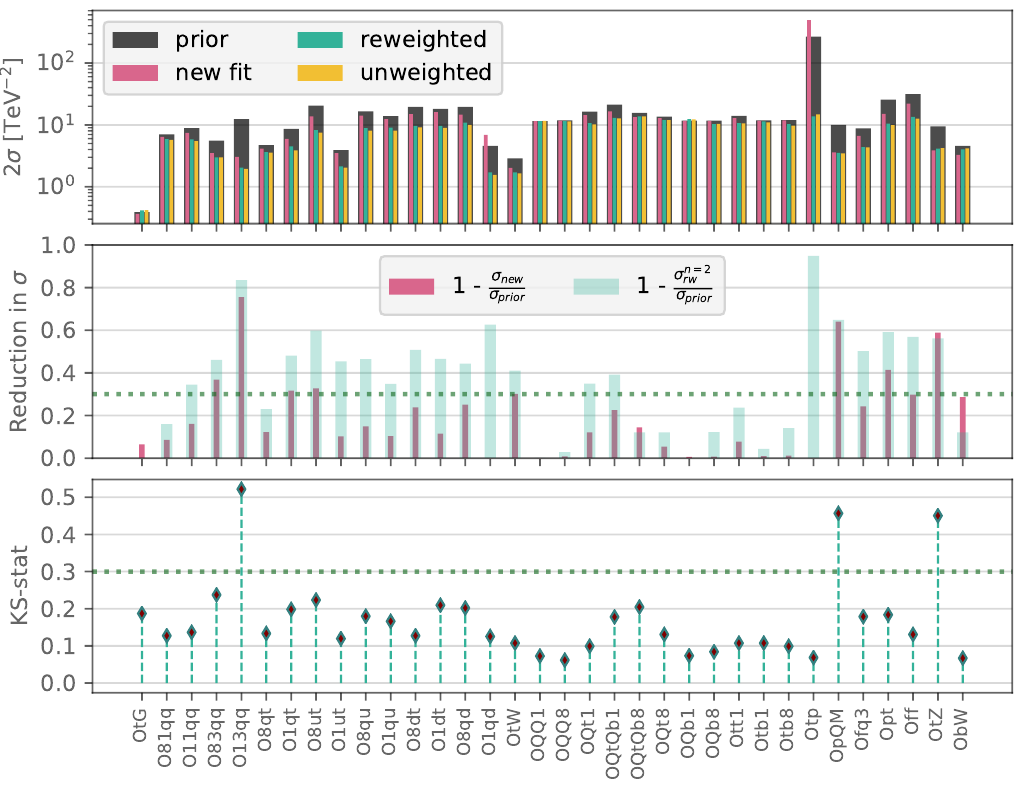
Figure 4.6: Same as Fig. 3.3 but now using the hybrid weights defined in Eq. (4.2) with p =